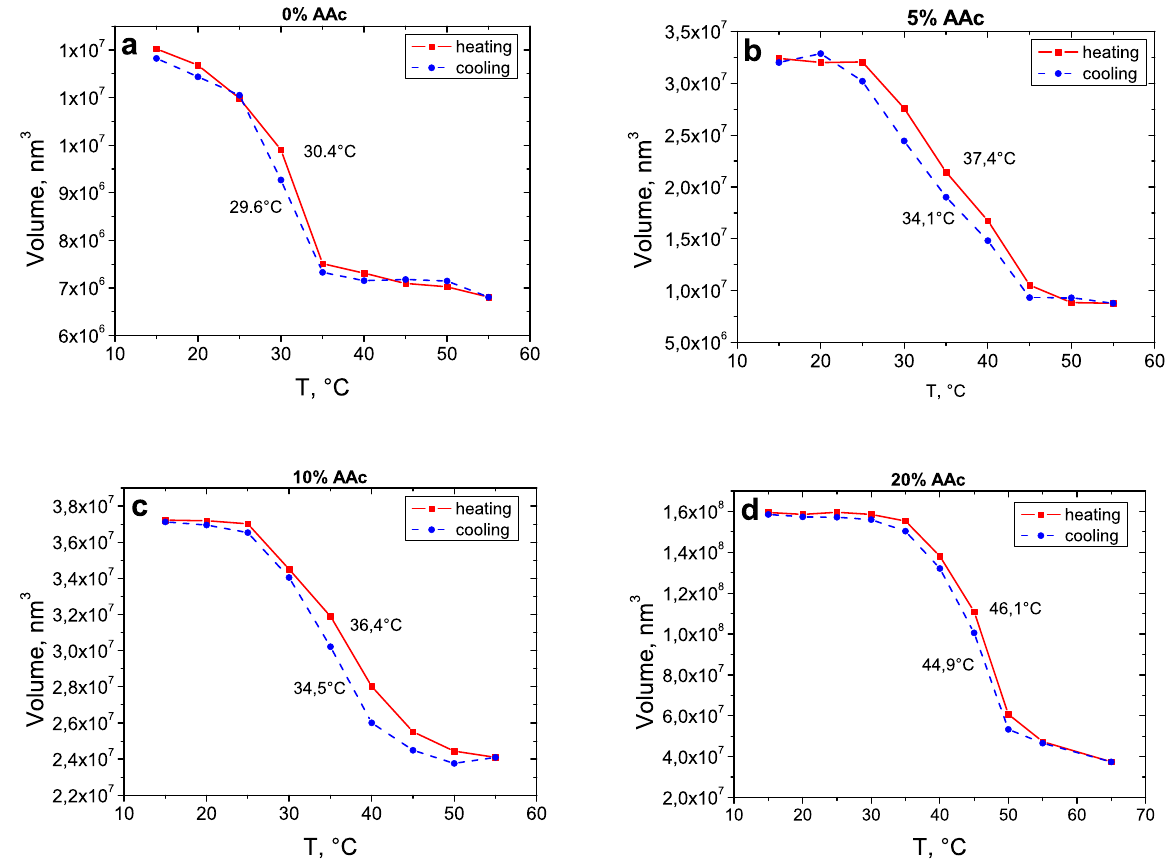
Table 3. Characteristics of adsorbed microgel particles for microgels with 0%, 5%, 10% and 20% AAc contents: LCST in heating and cooling cycles, volume of deposited microgels in dry state and in liquid at 20 ◦ C and 50 ◦ C, and particle volume in liquid cell (V T temperature T normalized by volume of dried particles (V